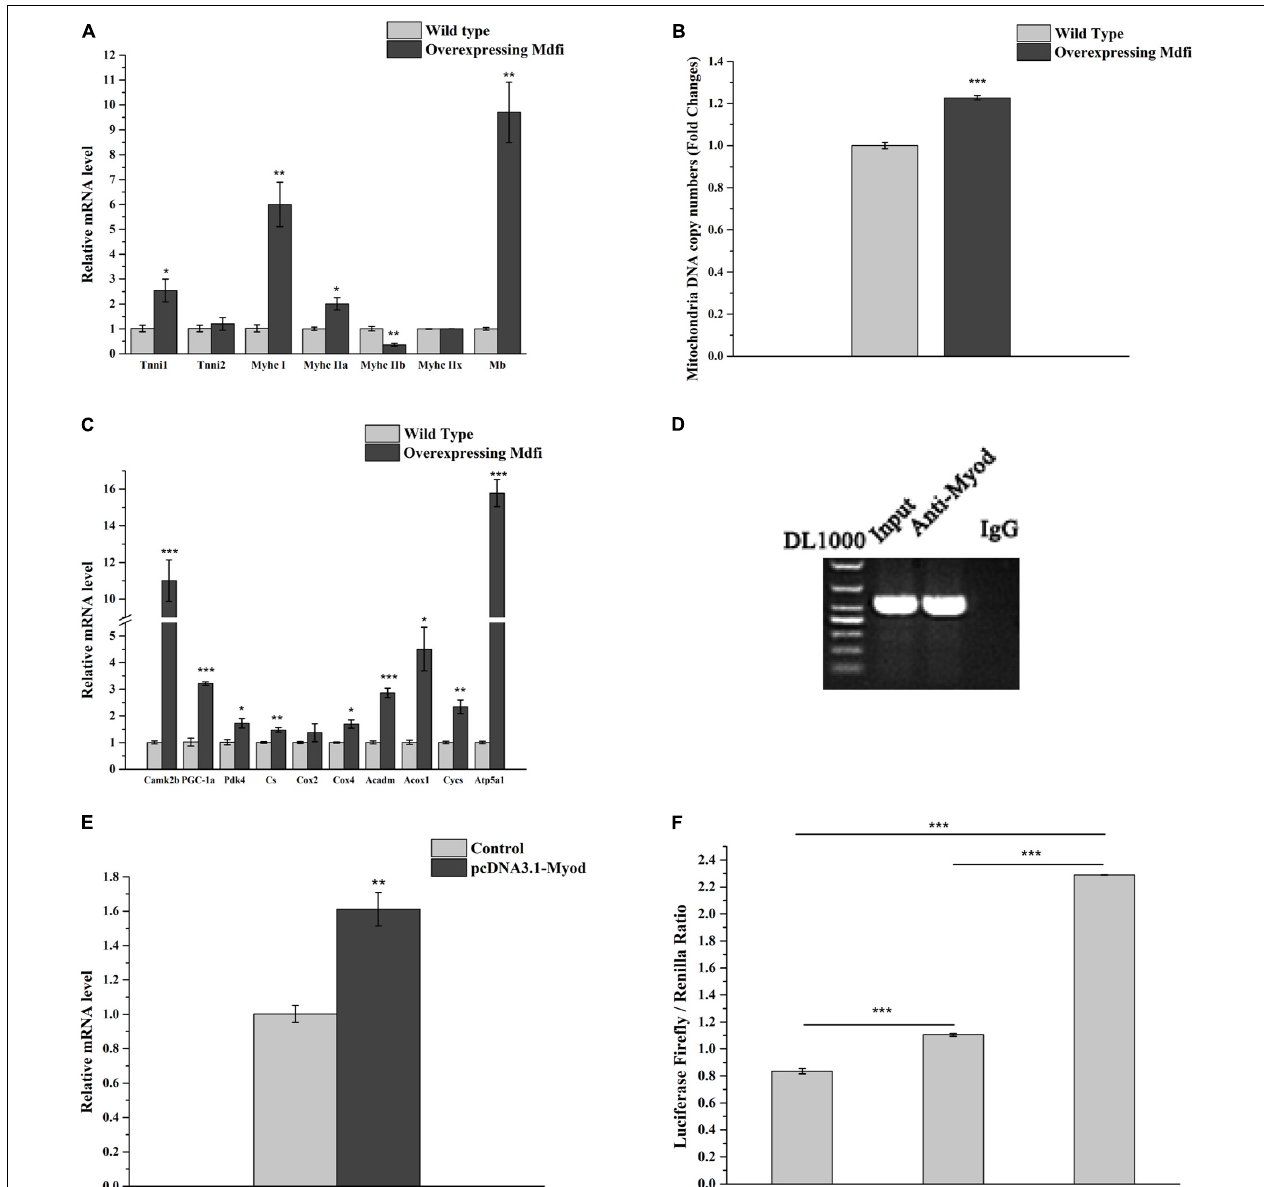
FIGURE 6 | Mdfi positively regulated the transformation of muscle fiber types from fast-twitch muscle to slow-twitch muscle in C2C12 cells. (A) qPCR identified the mRNA level of marker genes of different muscle fiber types in WT and Mdfi-OE C2C12 cells, respectively. (B) qPCR identified the relative copy number of mitochondrial DNA in WT and Mdfi-OE C2C12 cells, respectively. (C) qPCR identified the mRNA levels of energy metabolism-related genes in WT and Mdfi-OE C2C12 cells, respectively. (D) ChIP assay identified the binding of Myod to the Camk2b promoter region. (E) qPCR detection of the mRNA level of the Camk2b gene in C2C12 cells after Myod overexpressing. (F) The dual-luciferase reporter system identified the promoter activity of Camk2b after Myod overexpressing. *p < 0.05; **p < 0.01; *** p < 0.001. The results are presented as Mean ± S.E.M. of three replicates for each